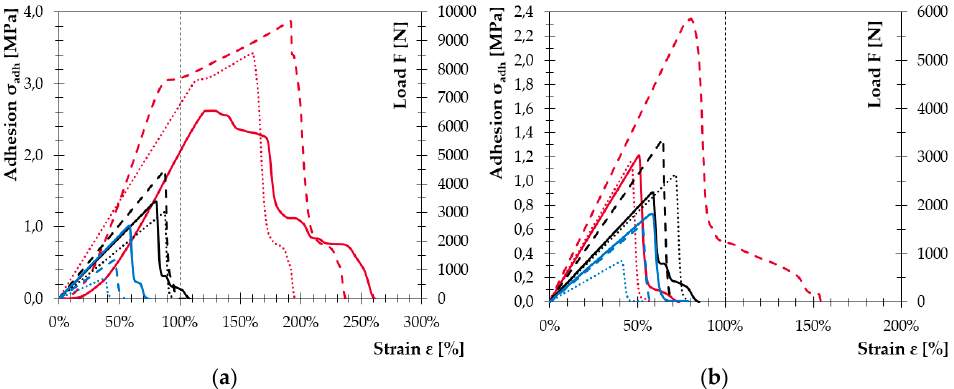
Figure 9. Comparison of average stress–strain curves from tensile test: ( a ) samples with primer and ( b ) samples without primer. Color marking: RED — WPC_45/45; BLACK — WPC_60/30; BLUE — WPC_58/30. Solid lines are samples with mechanical treatment, dashed lines are samples with physical treatment and dotted lines are samples with chemical treatment.